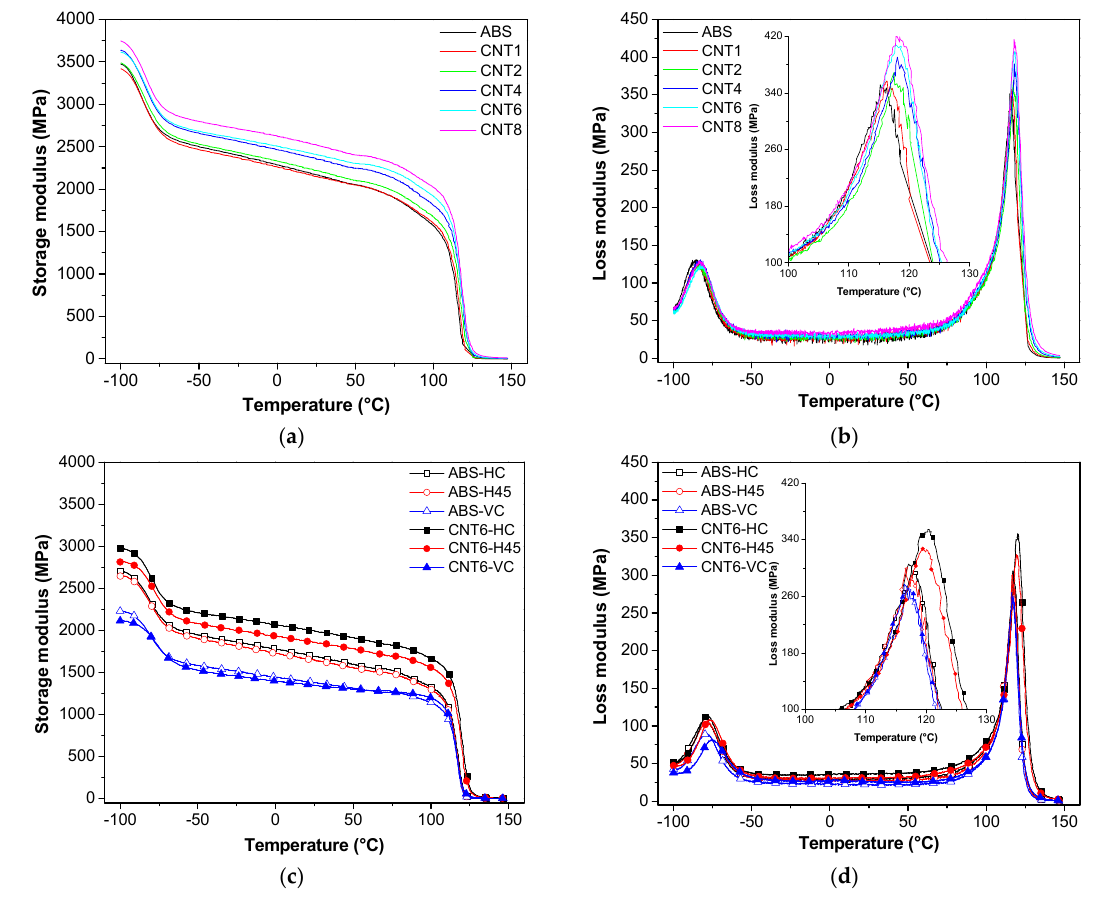
Figure 10. Dynamic mechanical thermograms of filament and 3D-printed samples ( a , c ) storage modulus ( E ’) and ( b , d ) loss modulus ( E ’’), of neat ABS and nanocomposite samples.